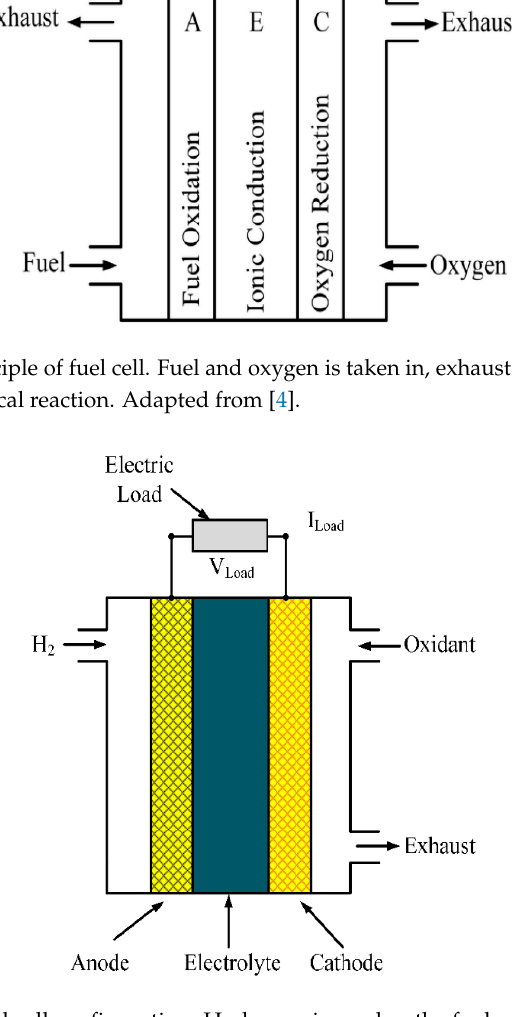
Figure 32. Hydrogen fuel cell configuration. Hydrogen is used as the fuel which reacts with oxygen and produces water and current as products. Adapted from [35]. Table 11. Comparison of different fuel cell configurations. Data from [2].